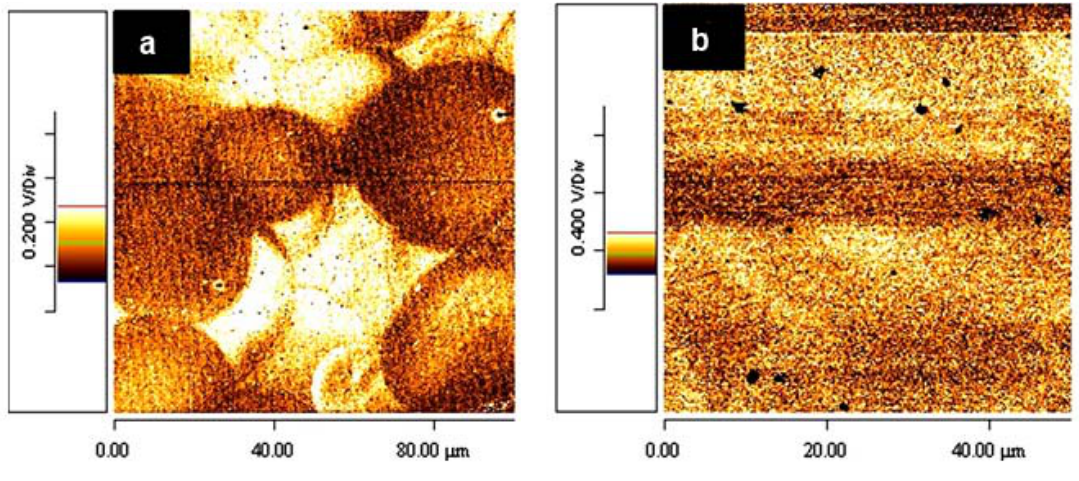
Figure 13. Conducting atomic force microscopy (C-AFM) images of ( a ) as-sprayed film; and ( b ) HSV-annealed film. Reprinted with permission from Elsevier